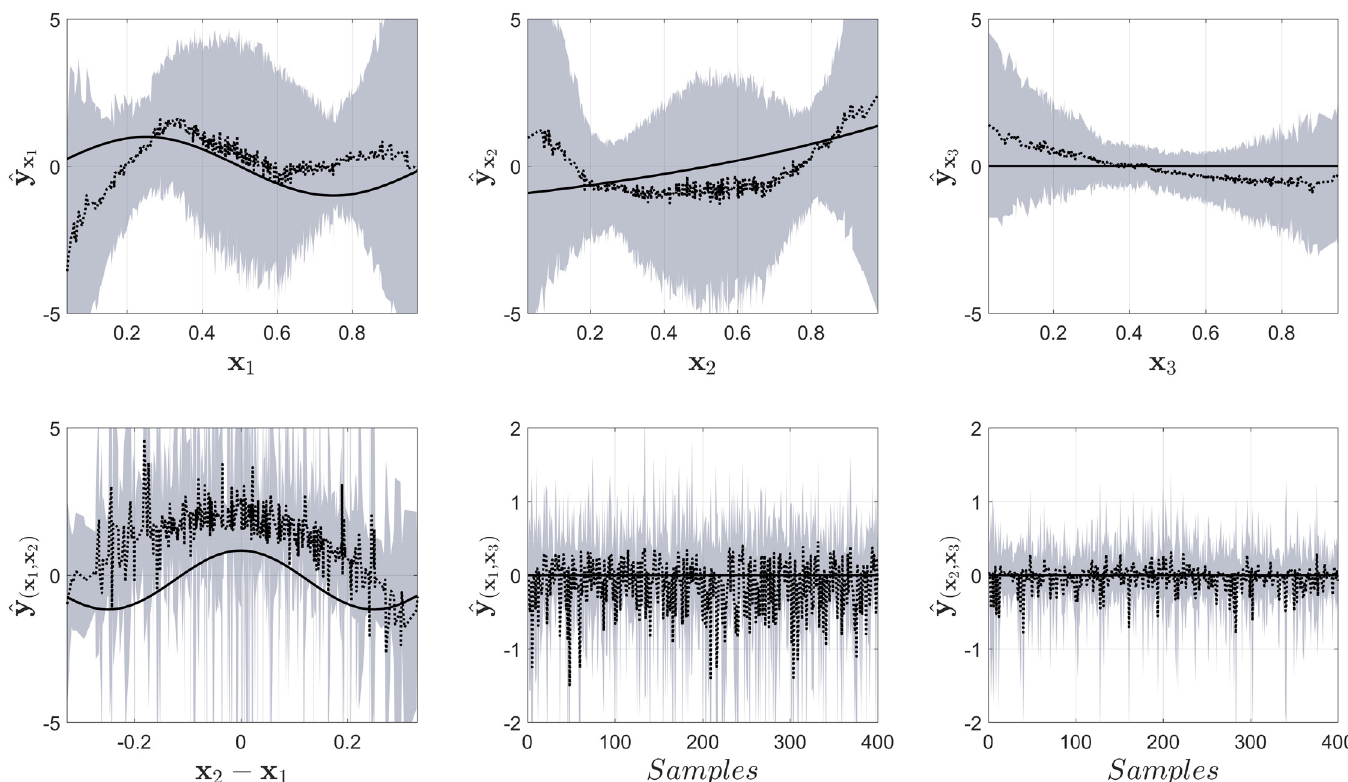
Fig 5. Output of the model for the decomposition of the measured output into the main and interaction effect contributions using COSSO-II in smoothing spline ANOVA models for second-order interactions. The black solid line represents the true component, the dotted black line represents the mean for the estimations using NObSP, and the gray area represents the 95% confidence interval obtained using